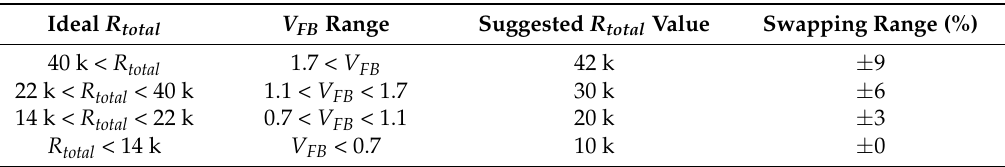
Figure 13. Frequency swapping logic circuit.